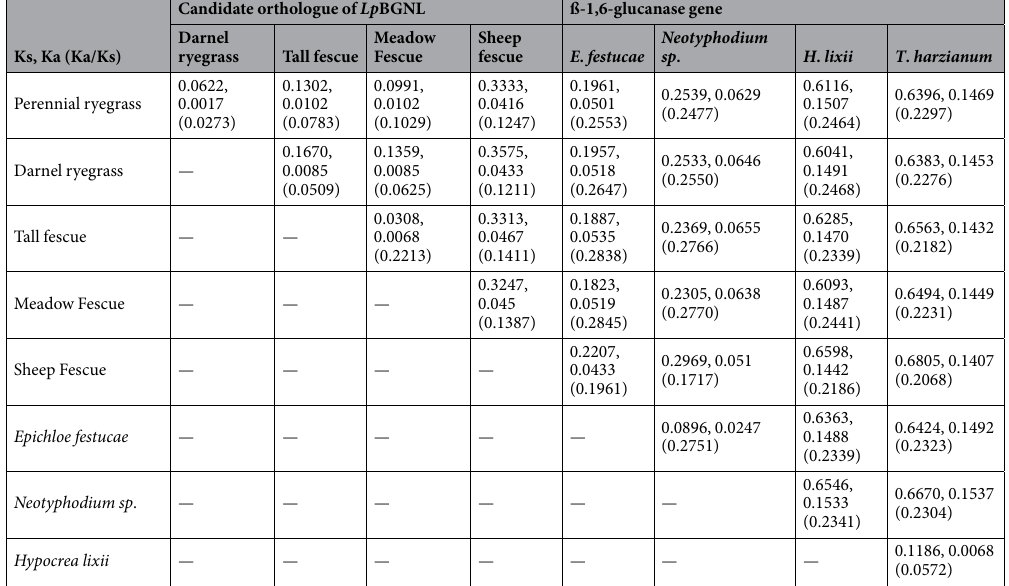
Table 2. Ks and Ka values, and Ka/Ks ratio within the Aryl-phospho-beta-D-glucosidase domain region between ß-1,6-glucanase(-like) gene